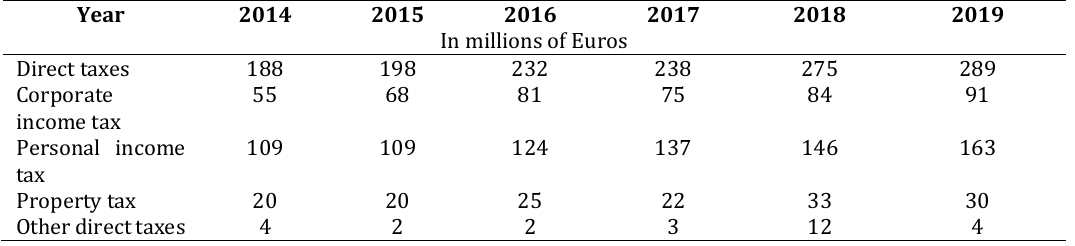
Table 3: Direct revenues in Kosovo in the period